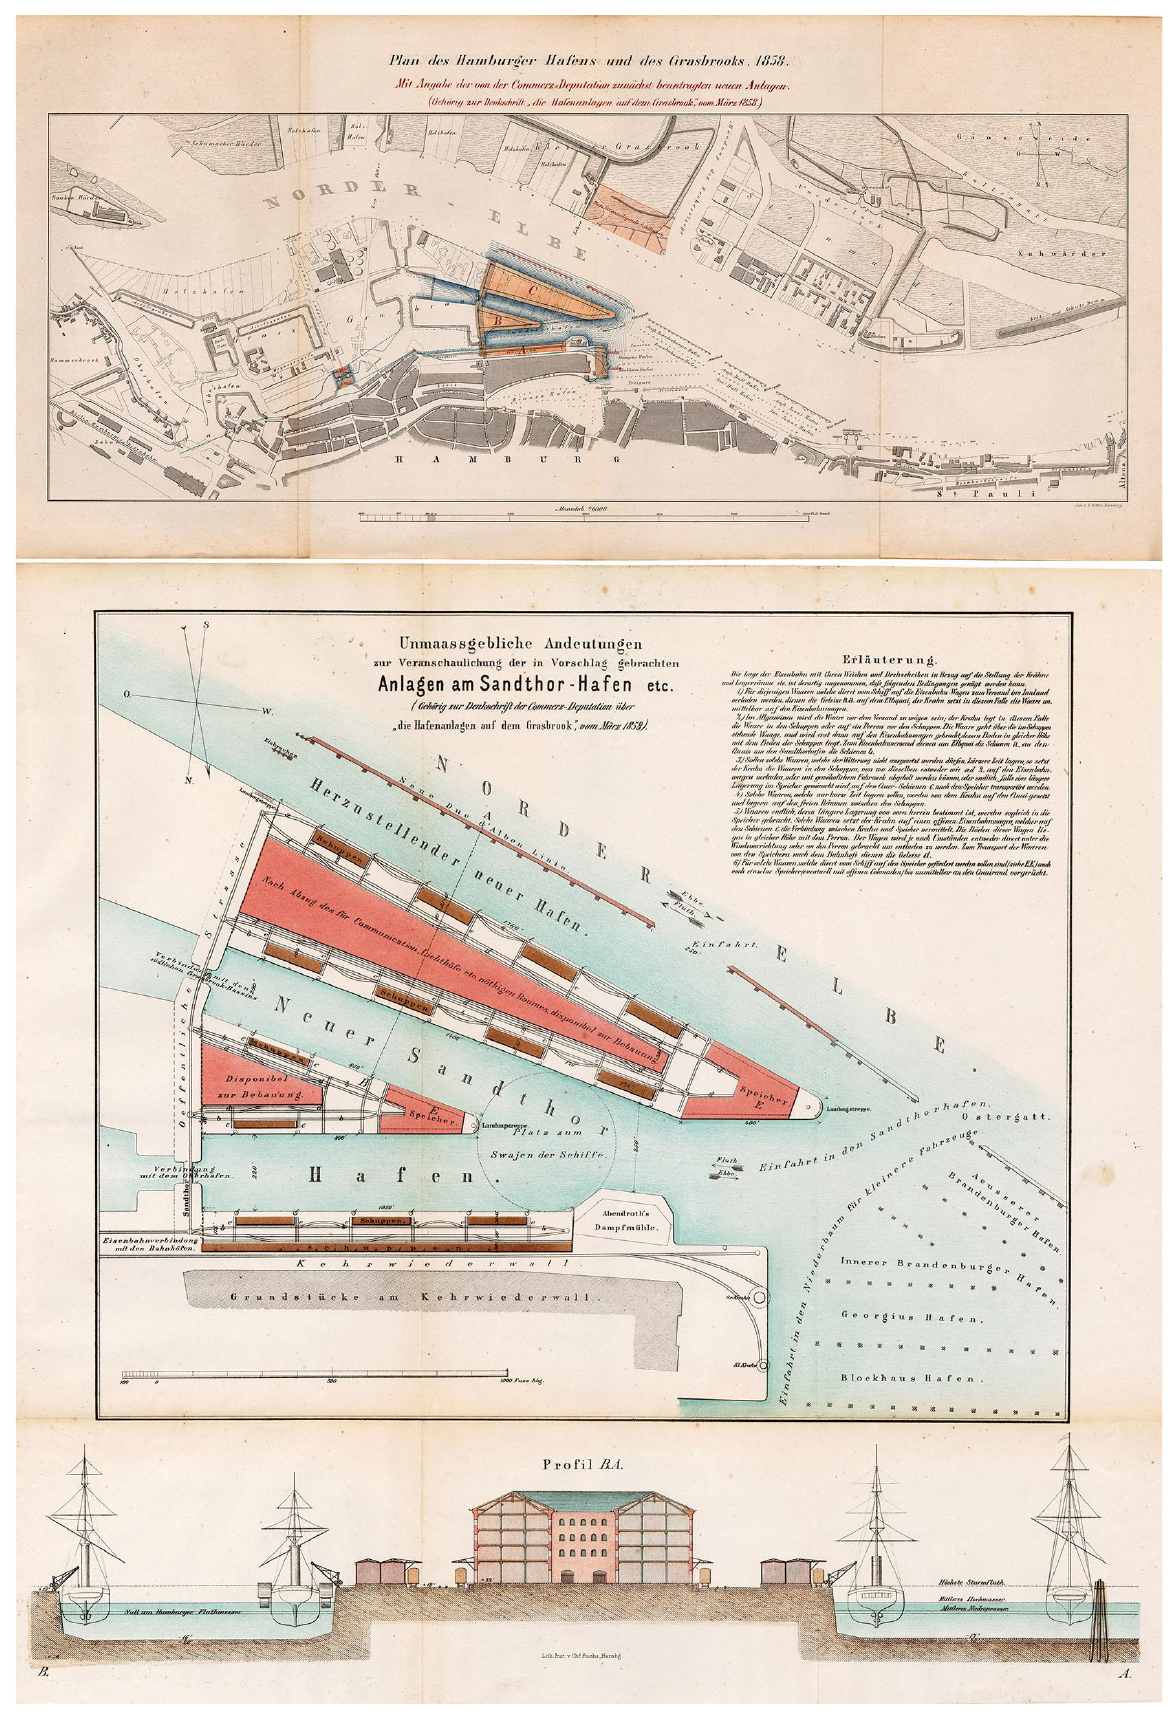
Figure 4. Plan of the port of Hamburg and the Grasbrook, with a proposal for used equipment at the Sandthor port. Source: Commerz‐Deputation